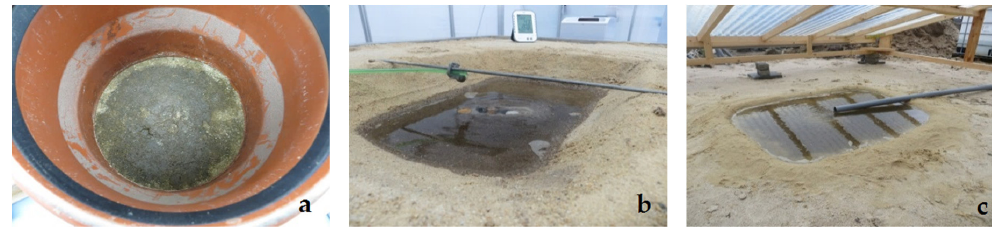
Figure 2. Infiltration basin: column ( a ), laboratory tank ( b ) and field infiltration unit ( c ).